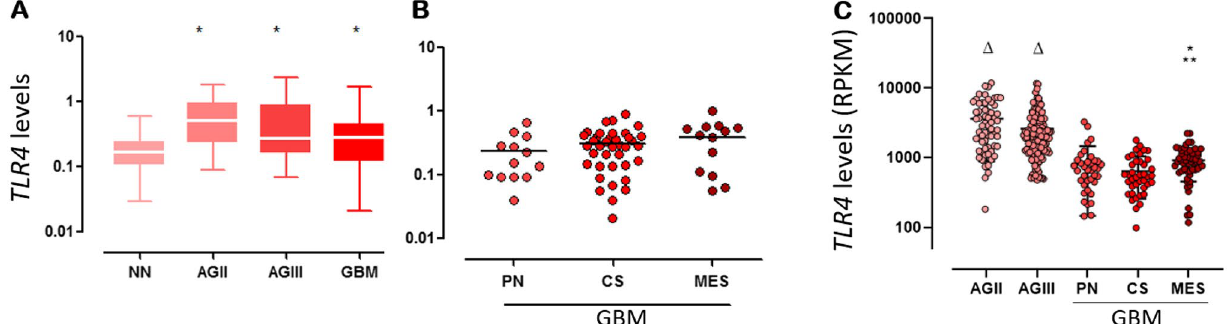
Figure 1. The TLR4 mRNA expression level was upregulated in human astrocytoma. ( A ) Box plot representation of TLR4 expression levels in our cohort of different astrocytoma malignant grades (AGII, AGIII, and GBM) and non-neoplastic (NN) brain samples (* p < 0.05 Kruskal–Wallis and Dunn tests). TLR4 expression levels (2 −ΔCt ) are log10 transformed, and the horizontal bars represent the median values. ( B ) The expression levels of TLR4 in the GBM molecular subtypes: proneural (PN), classical (CS), and mesenchymal (MES) in our cohort. ( C ) TLR4 expression analysis in the TCGA RNASeq data set is demonstrated by reads per kilobase per million mapped reads (RPKM), transformed in log10, including values for AGII, AGIII and GBM molecular subtypes. AGII and AGIII presented higher expression values (Δ) compared to GBM, and MES subtype presented significant higher than CS (*) and PN (**)( p = 0.001, Kruskal–Wallis, p = 0.001 Dunn